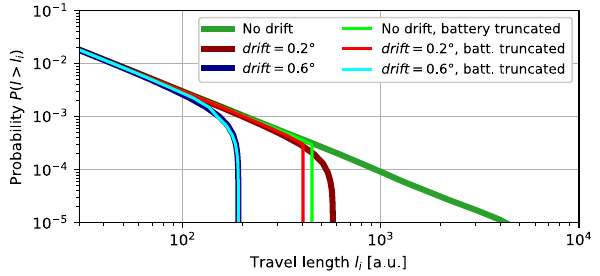
Figure 3. Effect of motion drift and battery constraints over travel length probability. For all traces in this figure α = 2.5 and no environment bounds. A pure implementation of Lévy search would strictly follow a power- law (dark-green trace). In practice, there are several intrinsic and extrinsic parameters that affect the planned strategy when implemented in a robot. Motion drift is caused by uncertainty in the locomotive plant (i.e., wheel slipping, inertial sensor accuracy, etc.) and effectively limits long travels. Two representative drift values are depicted in red and blue. Energy limitations are considered in the “battery truncated” case (brighter red, green and blue traces) where individual travels are limited in length to use at most 10% of the available battery (“Robot simulation models”